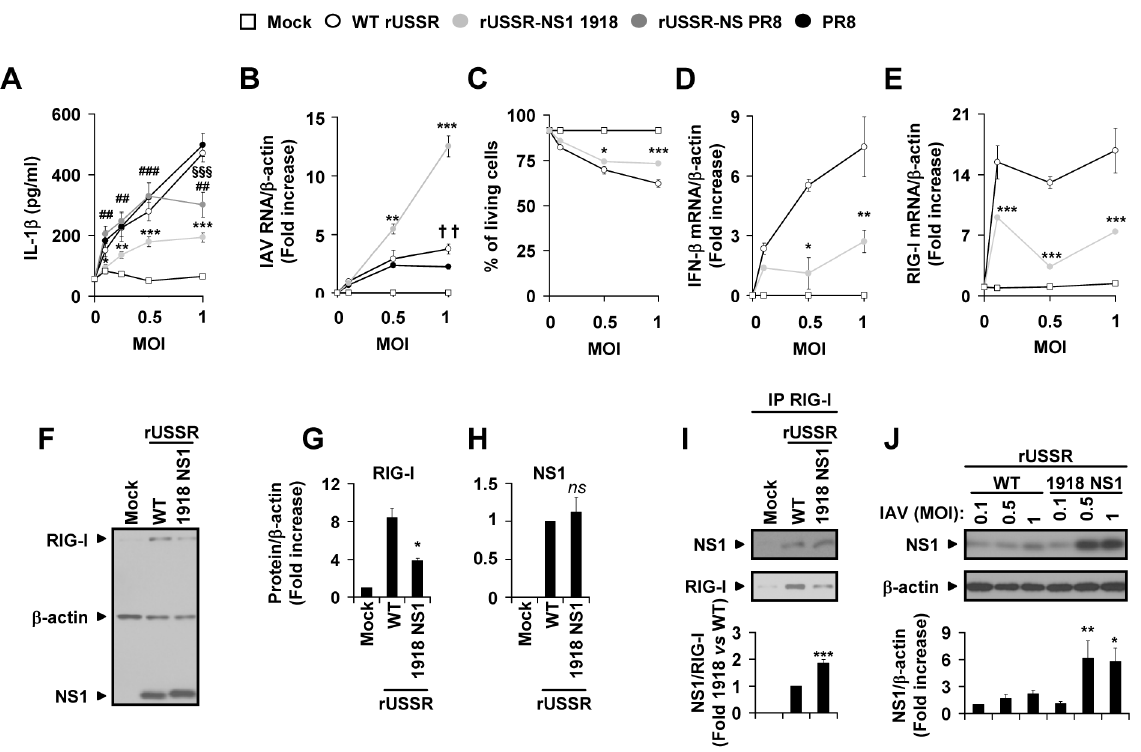
Figure 6. The pandemic virus 1918 NS1 inhibits IL-1 b response and downregulates type I IFN–mediated RIG-I upregulation. (A) NHBE cells from five donors were either mock-treated or infected for 18 h with WT PR8, WT rUSSR, rUSSR-NS1 1918, or rUSSR-NS PR8 at various MOIs. IL-1 b production in cell-free supernatants was quantified by ELISA. (B) Virus M2 RNA levels normalized with respect to b -actin levels. (C) Percentage of living cells determined by LDH assay. (D) IFN- b and (E) RIG-I mRNA levels normalized with respect to b -actin levels. (B, D and E) Data are presented as a mean 6 SEM of quadruplicates of qRT-PCR of two experiments on NHBE cells from donor 111011. Results are expressed as fold-increase relative to WT rUSSR-infected cells at an MOI of 0.1 (B and D) and relative to unstimulated cells (E). (F–H) NHBE cells were either mock-treated or infected with either rUSSR WT or NS1 1918 for 18 h. (F) Immunoblot of RIG-I, NS1, and b -actin. Quantification of (H) the RIG-I/ b -actin and (G) the NS1/ b -actin protein signal ratios. (I) Endogenous interactions between RIG-I and either USSR or 1918 NS1 proteins were assessed in NHBE cells stimulated as in (F). RIG-I was immunoprecipitated with anti-RIG-I antibody (IP RIG-I) and immunoblotted (RIG-I). NS1 interaction with RIG-I was analysed by immunoblotting NS1 (NS1) after RIG-I immunoprecipitation and The NS1/RIG-I protein signal ratio in immunoprecipitated samples was quantified. (J) Immunoblot of b -actin, USSR and 1918 NS1 proteins in NHBE cells infected with multiple MOI of recombinant viruses for 18 h. The NS1/ b -actin protein signal ratios in these NHBE cells are presented on the bottom panel. (F to J) One representative immunoblot out of three is presented. Results are presented as a mean 6 SEM of immunoblots from three independent experiments (G, I and J) and from six independent experiments (H). Data are expressed as a fold increase relative to mock-treated cells (G), WT rUSSR-infected cells (H and I) or WT rUSSR infected-cells at an MOI of 0.1 (J). (A–I) * p , 0.05, ** p , 0.01, and ***p , 0.001 NS1 1918 compared with WT rUSSR infected cells. # p , 0.05, ## p , 0.01, and ### p , 0.001 NS PR8 compared with NS1 1918 rUSSR. 1 p , 0.05, 11 p , 0.01, and 111 p , 0.001 NS PR8 compared with WT rUSSR. On panels A and B, * p , 0.05, ** p , 0.01, and ***p , 0.001 also comparing NS1 1918 with PR8. {{ p , 0.01 comparing WT rUSSR with PR8.